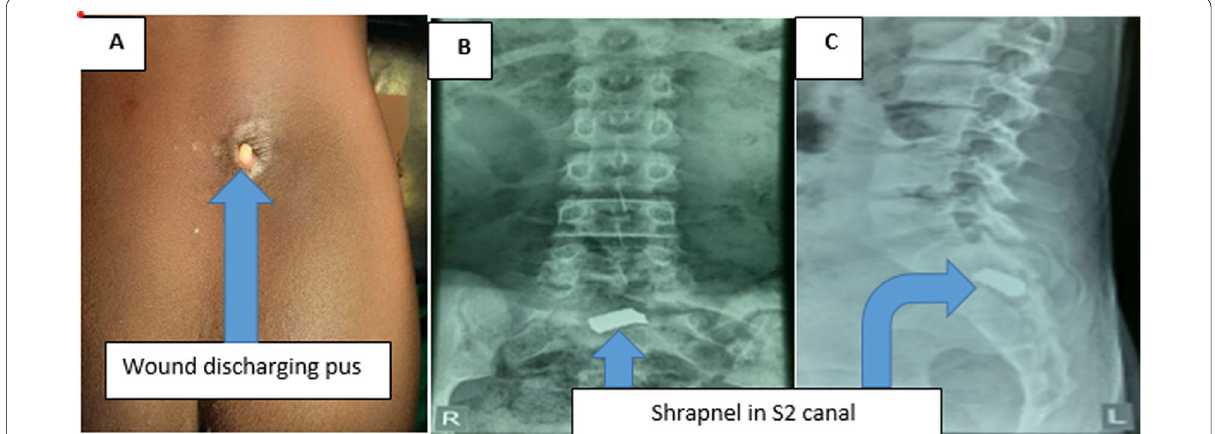
Fig. 1 The entry wound discharging pus ( a ), lumbosacral X-ray, anteroposterior view ( b ) and lateral ( b ) showing the shrapnel in the second sacral (S2) vertebra